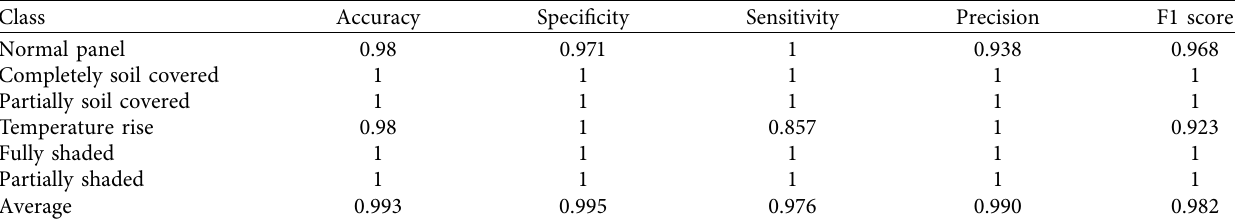
Figure 23: Confusion matrix for thermal images with fault. Table 8: Statistics of thermal images in SN.